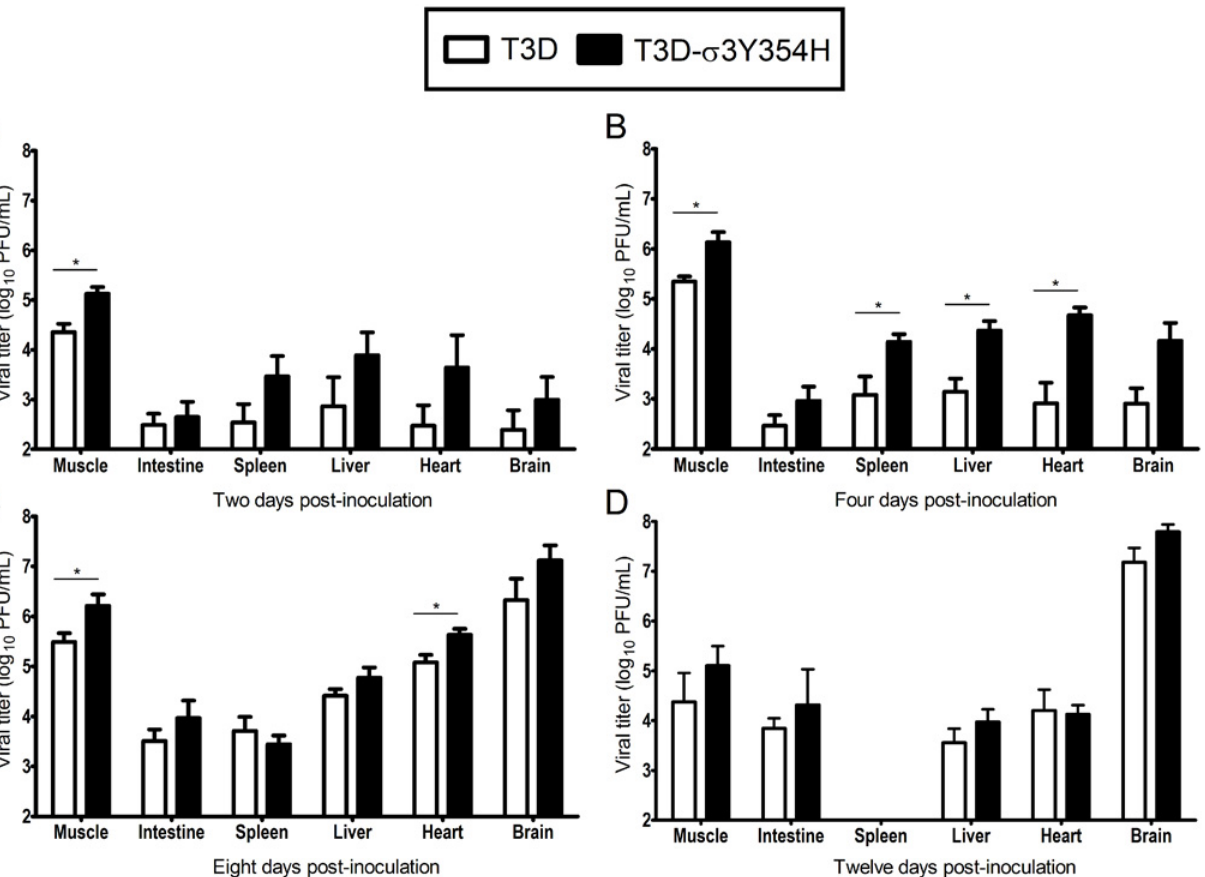
Fig 2. Viral loads are higher in mice infected with T3D- σ 3Y354H. Newborn C57BL/6J mice were inoculated in the left hindlimb with 10 5 PFU of either T3D or T3D- σ 3Y354H. At days 2 (A), 4 (B), 8 (C), and 12 (D) post-inoculation, animals were euthanized, left hindlimb muscle, intestine, spleen, liver, heart, and brain were excised, and viral titers in organ homogenates were determined by plaque assay. Results are expressed as mean viral titers for 6 to 9 animals for each time point. Error bars indicate standard errors of the means. * , P < 0.05 as determined by Mann-Whitney test in comparison to T3D.